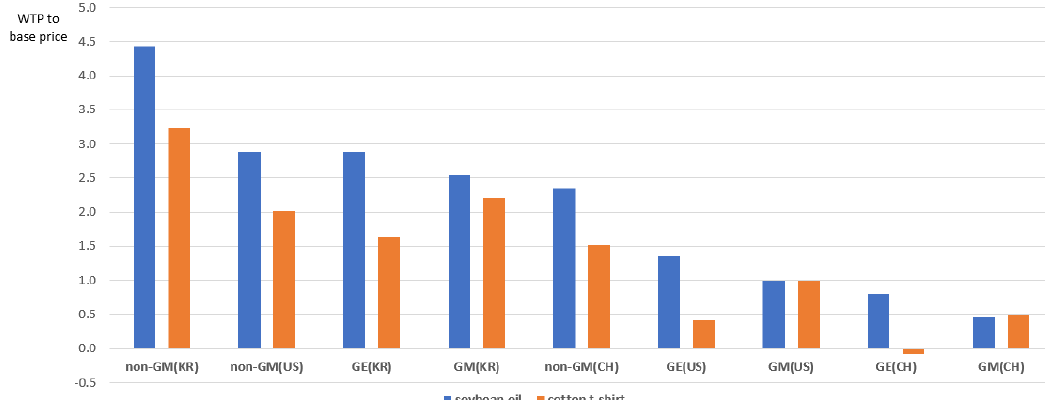
Figure 1. WTP to the base price by an attribute level combination.